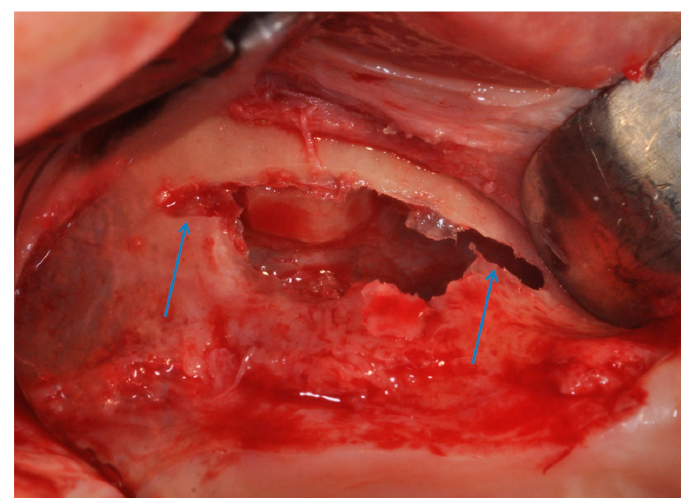
Figure 9. The antrostomy was performed with two lines of 2 – 3 mm, mesial and distal, was created at the top of the antrostom and sinus membrane was elevated.